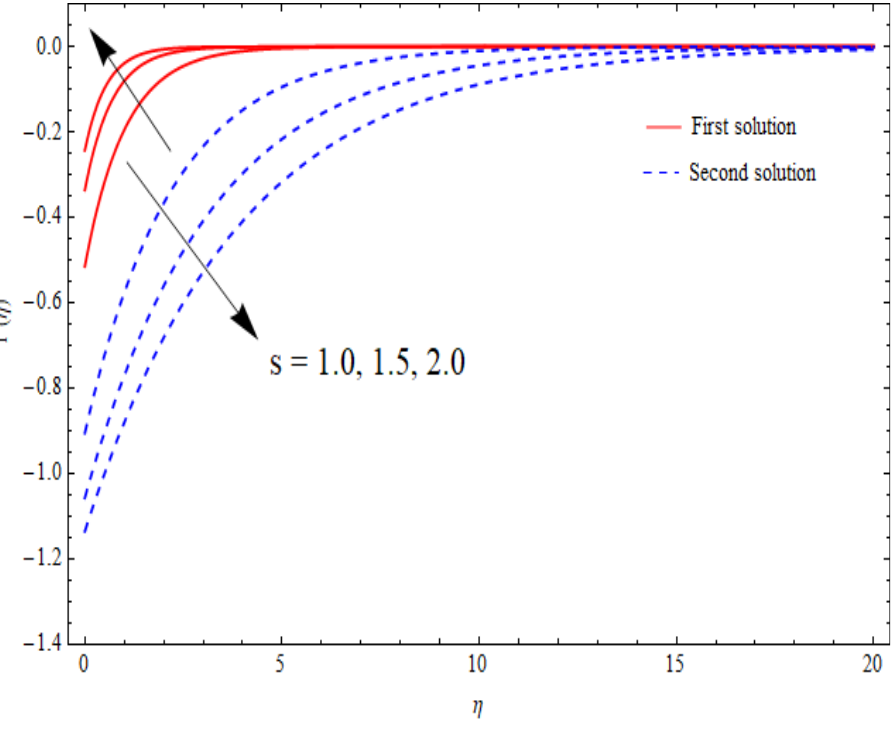
Figure 9. Velocity profiles f (cid:48) ( η ) for distinct s when λ = − 1.5, k 1 = 1 = γ , δ = − 1, ϕ 1 = 0.1 = ϕ 2